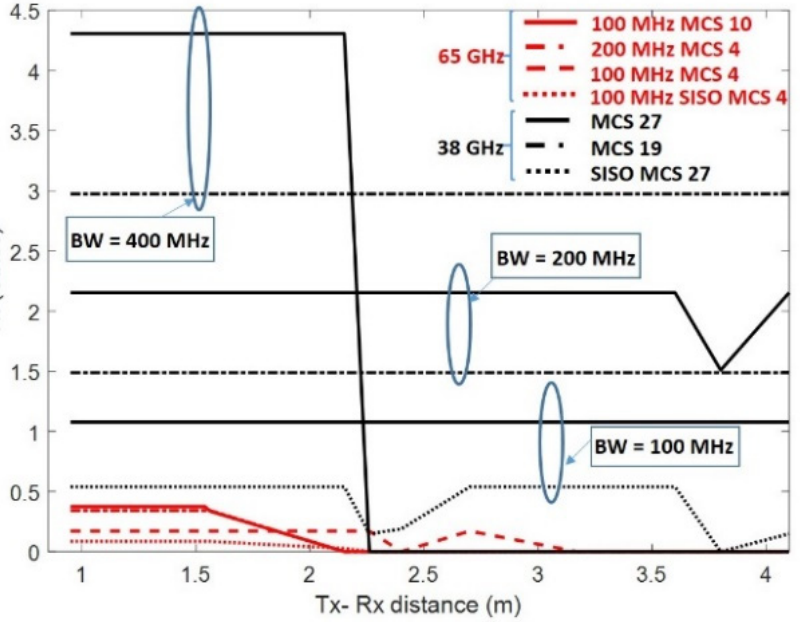
Figure 7. Maximum throughput at 38 and 65 GHz using HBF algorithm (BW = 100, 200, and 400 MHz).